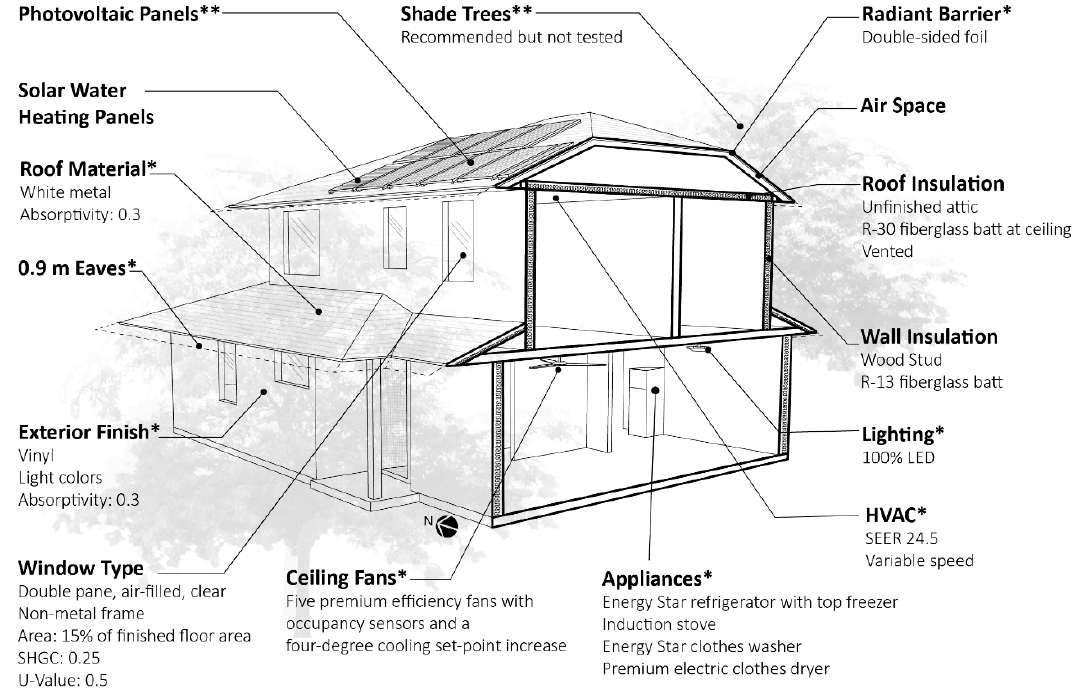
Figure 6. Energy-optimized model depiction: Items with an asterisk (*) were modified from the IECC 2015 minimum energy model, whilst items with two asterisks (**) were not modeled but are recommended for consideration.